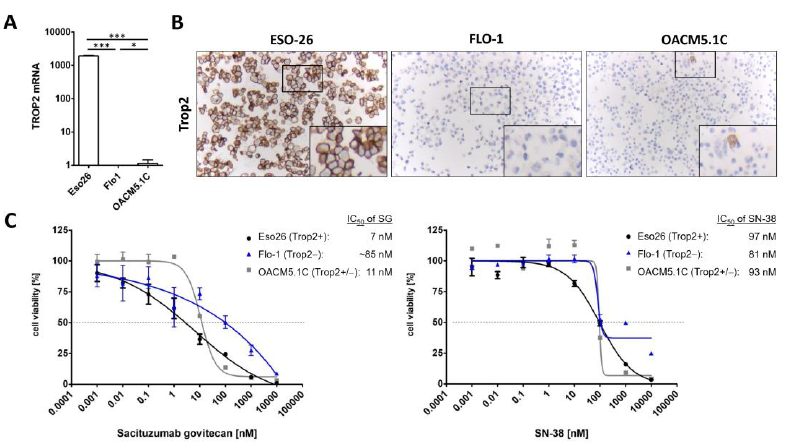
Figure 1. Transcript counts of TACSTD2, the gene for TROP2, from RNA-seq data normalized for sequencing depth and RNA composition using the median of ratios method ( A ) and protein expression by IHC staining with anti-TROP2 antibody ( B , ab214488, abcam, 200x) of EAC cell lines ESO-26, OACM5.1C and FLO-1 in vitro. ( C ) Viability assay of Eso-26, OACM5.1C, and Flo-1 treated with concentrations of Sacituzumab govitecan ( left ) or SN-38 ( right ), detected by CellTiterGlo 2.0 (Promega). Values are presented relative to vehicle-treated control as means ± SEM with a non-linear regression curve to determine the IC50, n = 3, * p -value < 0.05, *** p -value < 0.001, two-sided unpaired Student ’ s t -test. 3.4. TROP2 Positive EAC Tumors Are Sensitive to Sacituzumab Govitecan We generated subcutaneous xenografts in NSG mice with the cell lines Eso26 (TROP2+) and Flo1 (TROP2-). After sufficient tumor growth, mice were treated with either SG or vehicle solution for 10 days. Strikingly, SG showed no effect on TROP2 negative tumors (FLO-1, size after treatment 524.6 mm 3 , negative control 697.3 mm 3 ) while signifi- cantly decreasing the growth of TROP2 positive tumors (Eso26, size after treatment 27.9 mm 3 , negative control 597.4 mm 3 , Figure 2A,B). Of note, TROP2 negative Flo1 tumors grew much slower than positive Eso26 tumors. Dissected tumors after treatment were analyzed for TROP2 expression by IHC and showed persistence of uniform positive or negative TROP2 expression throughout the treatment. In the frame of health monitoring, we routinely determine the body weight of mice. We have not detected any toxicity (Sup- plementary Figure S2).